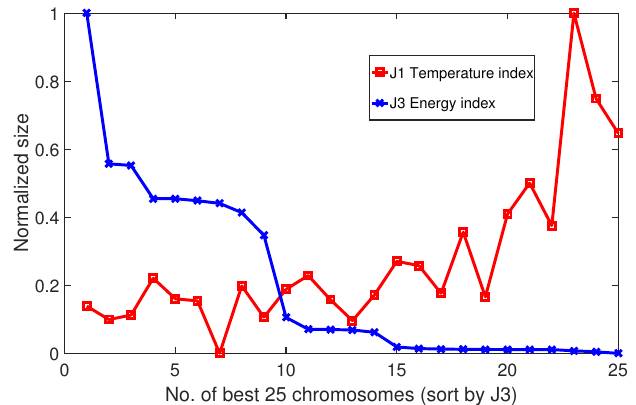
Figure 12. Negative correlation between temperature and energy cost indexes (25 pairs of chromosomes belonging to the Pareto